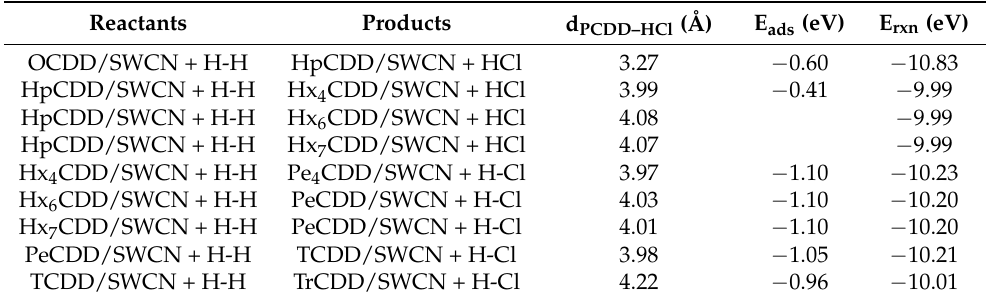
Table 2. Energies for the adsorption and reactions modeled on the SWCN model, including the final distance between the dehydrogenated product PCDD and a HCl